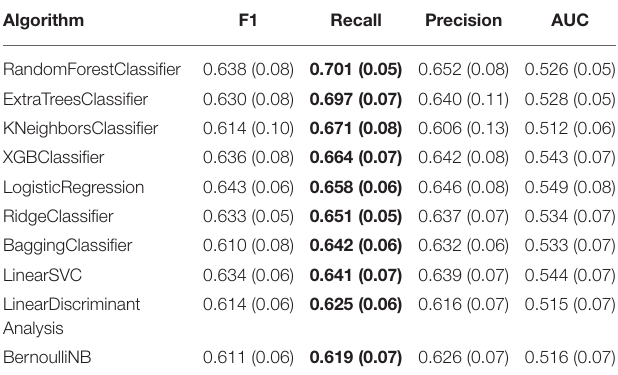
Algorithm F1 Recall